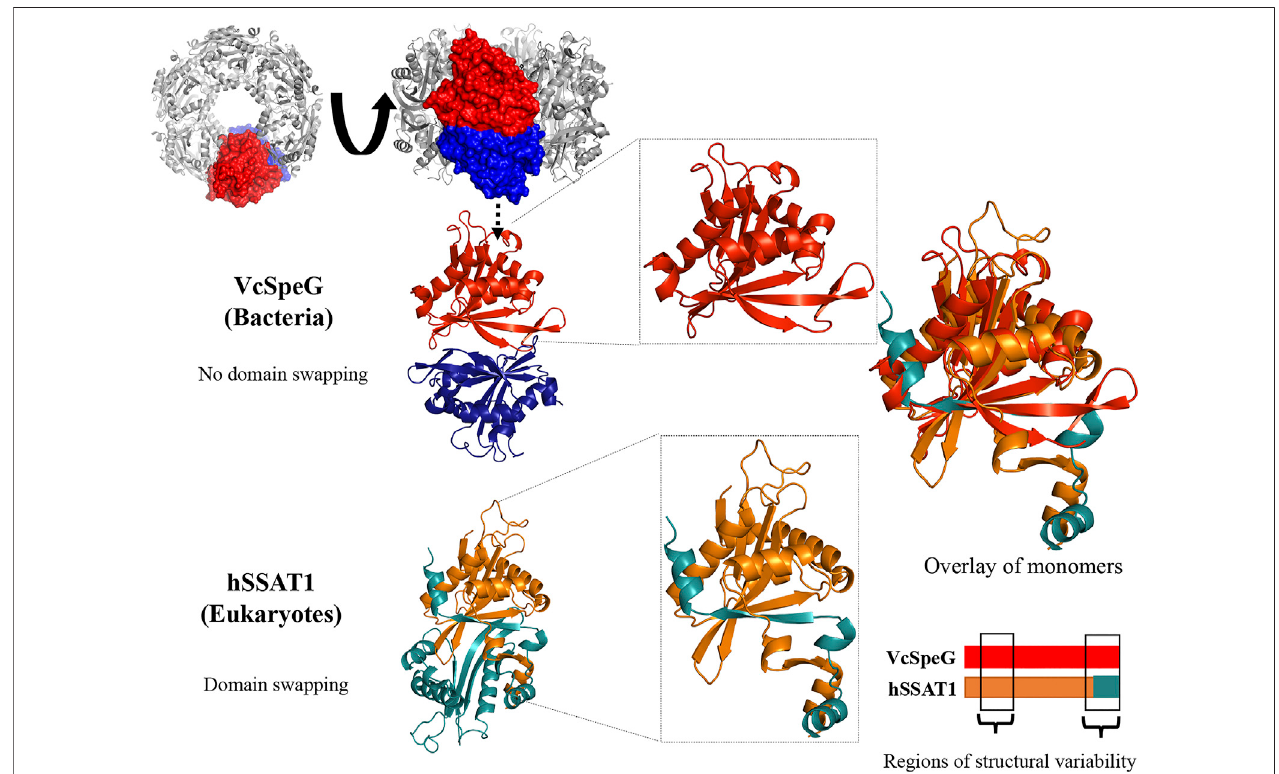
FIGURE 1 | VcSpeG dodecamer and hSSAT dimer. The ribbon diagram and surface view for the VcSpeG (PDB ID: 4r87) dodecamer, dimer, and monomer are shown in gray,redand blue. Thedodecamer iscomprised oftwohexamers ontopofeach other. Twomonomersofdifferenthexamers ofthedodecamer areinred and blue and a zoomed view shows a single monomer. No domain swapping occurs between these monomers. The ribbon diagram of the hSSAT1 protein (PDB ID: 2b4b) monomersofthe dimer are shown inorange and teal. Domain swapping occurs betweentwomonomers, and azoomed view oftheswapped region isshown. An overlay of both monomers of the VcSpeG and hSSAT1 protein structures and regions of variability between the two proteins is